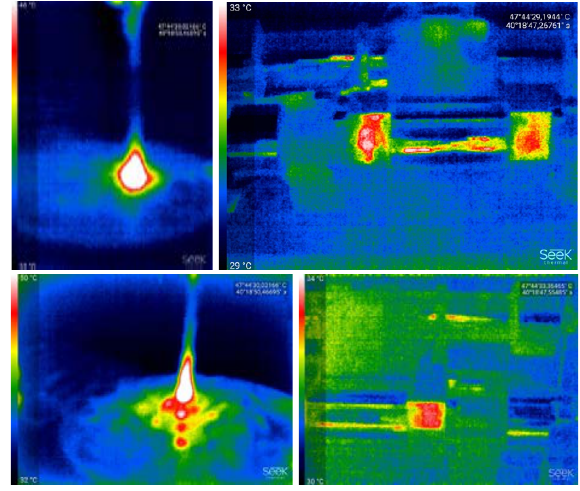
Fig. 4. The example of fixing data Figure 5 shows examples of IR images. Images obtained during the operation of devices. The data were obtained only in the infrared range without the presence of a reference image recorded in the visible spectrum. The absence of a reference image does not allow us to form the boundaries of objects.